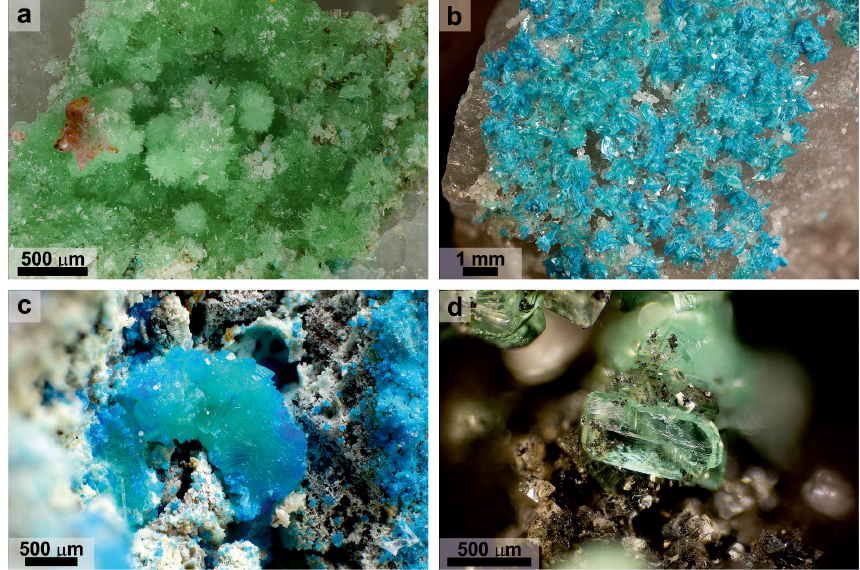
Figure 8. (a) Geminite crystals on the milky-white quartz. Geschieber vein, Daniel level, Svornost mine, Jáchymov. (b) Geminite crystals partially overgrown by bluish lavendulan. Matrix is represented by quartz. Geschieber vein, Daniel level, Svornost mine, Jáchymov. (c) Gem- inite aggregate partially overgrown by bluish yvonite. White fine-grained phase is arsenolite. Giftkies adit, Jáchymov. (d) Geminite crystal in a cavity of strongly altered native arsenic. Octahedral colourless crystals belong to arsenolite. Geister vein, sixth Geister level, Rovnost mine, Jáchymov. Photograph (a) by Stephan Wolfsried and (b–d) by Pavel